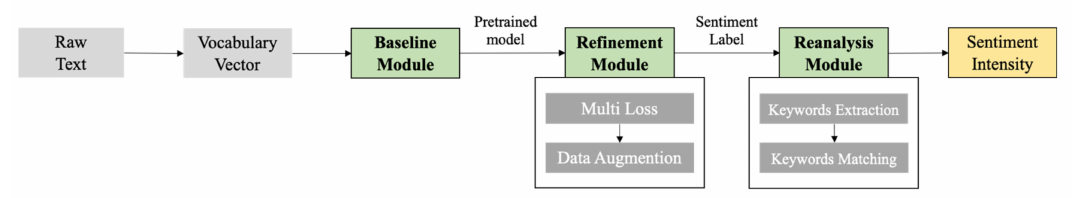
Figure 3. The sentiment classification algorithm